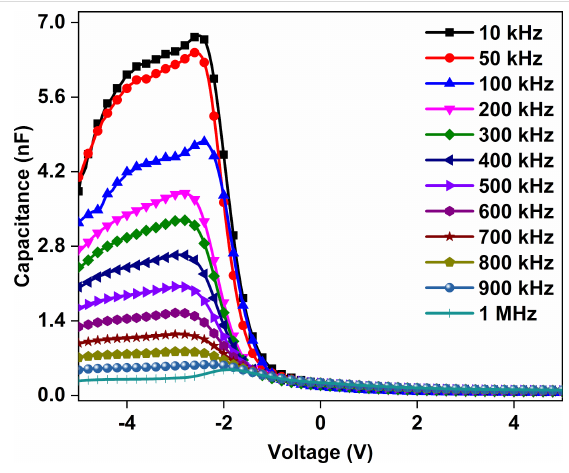
Figure 9: C – V graphs of the Au/CuNiCoS 4 /p-Si photodiode for in- creasing frequencies.